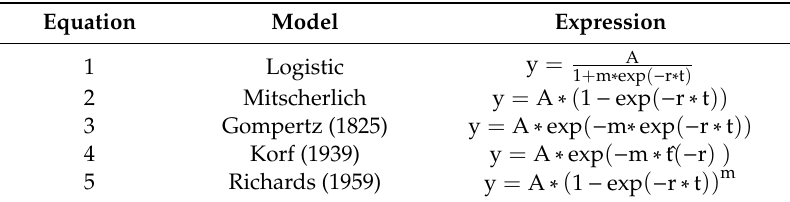
Table 3. Theoretical growth